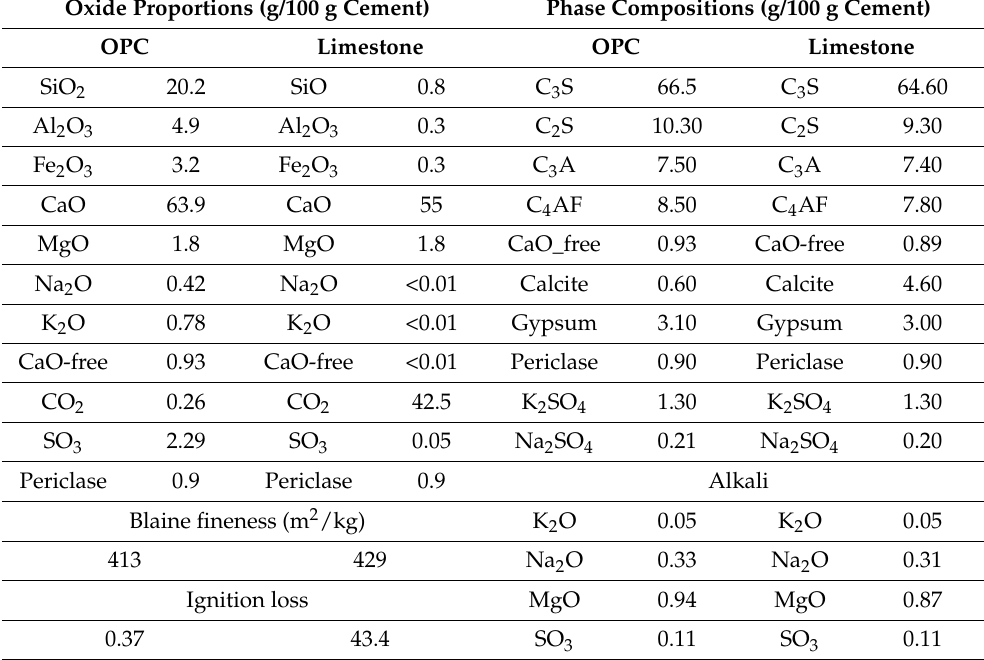
Table 3. Cement oxide proportions (taken from